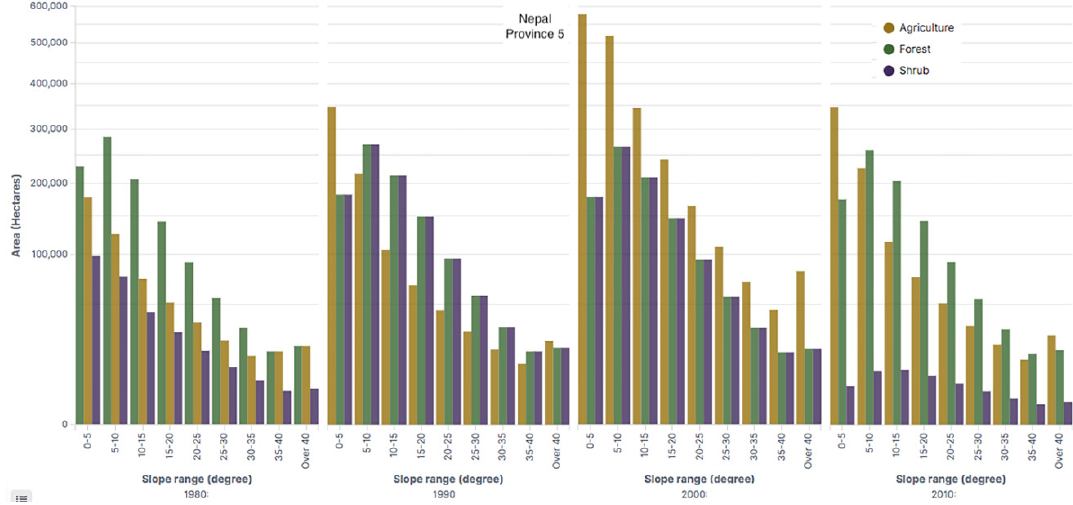
Figure 16. Province 5: forest, shrubland, and agricultural areas of Nepal by 9 elevation classes for 1980, 1990, 2000, and 2010. Table 11. Province 5: land use as a percentage of total area of forest, shrubland, and agriculture for 1980, 1990. 2000, and 2010 for entire Nepal. ((Individual land-use area for a slope class/sum of forest + shrubland + agriculture) * 100).